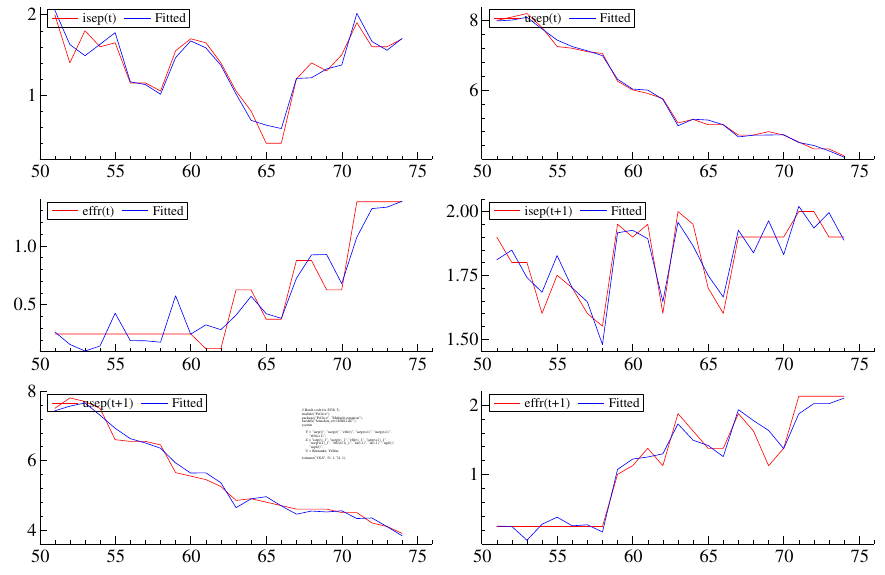
Figure 7. Actual versus Fitted FOMC